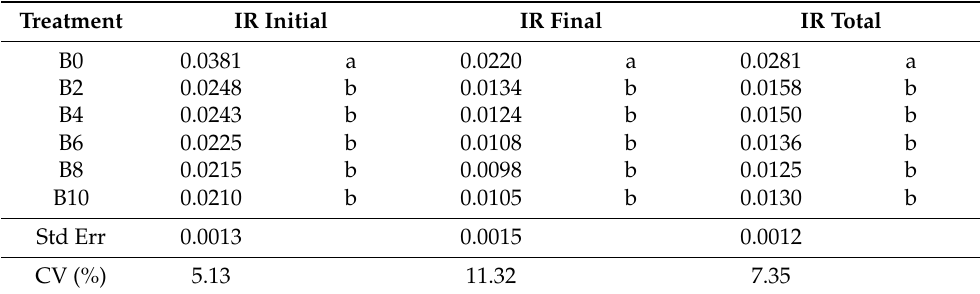
Table 7. Average infiltration rates (I R cm sec − 1 ) in the soil–biochar mixtures (treatments) at